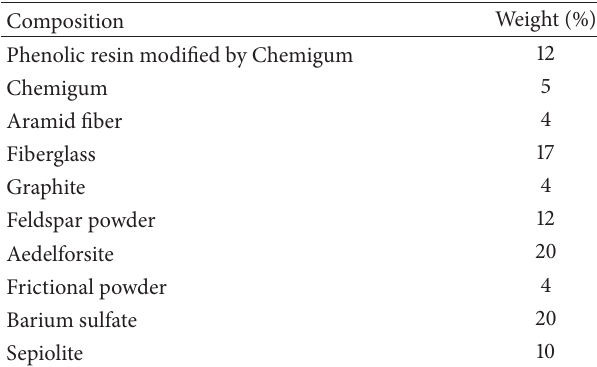
Table 1: Composition weights of the WSM-3 nonasbestos brake shoe.